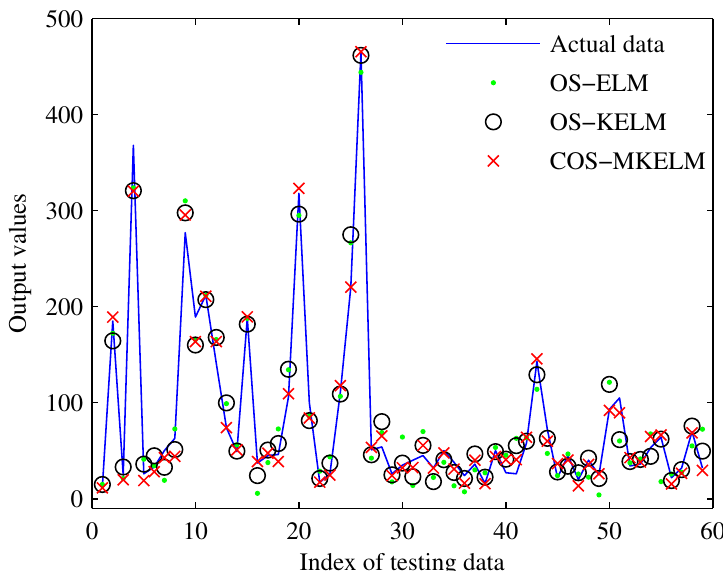
Figure 2. Output values for testing data of d 2